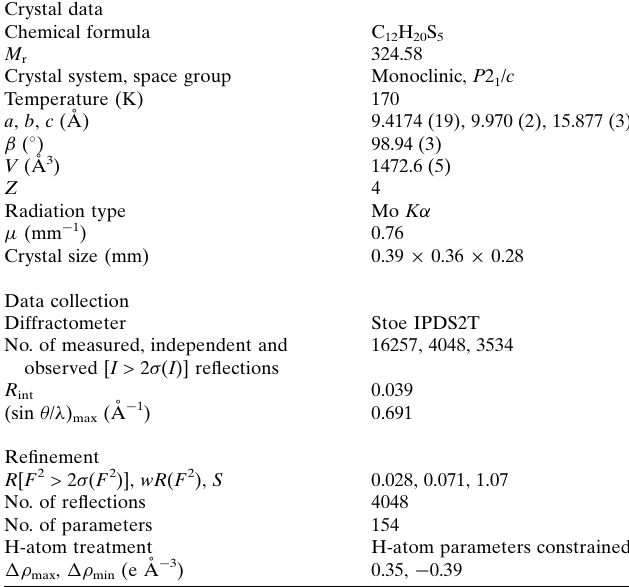
Table 2 Experimental details.